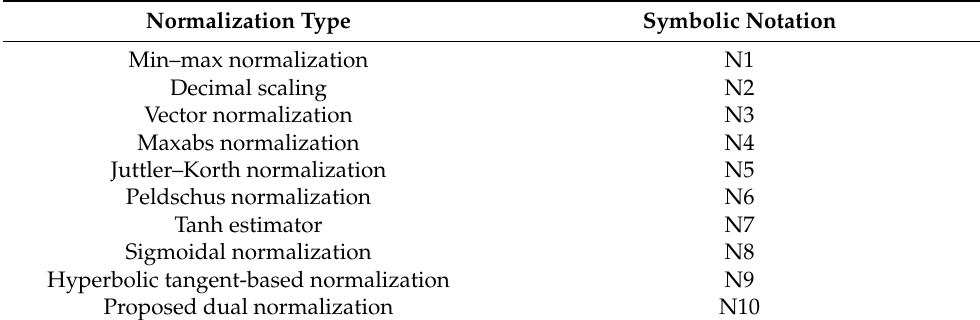
Table 4. Symbolic Notation for Normalization Types.